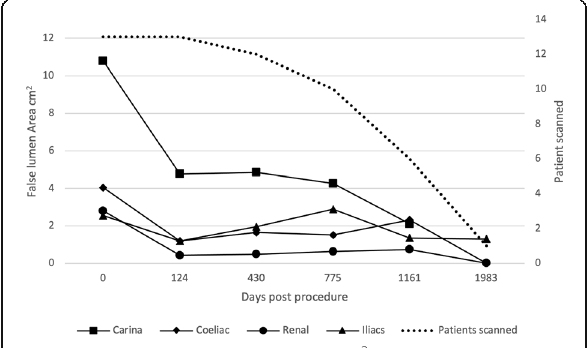
Fig. 5 Average false lumen aortic area (cm 2 ) excluding cases requiring reintervention